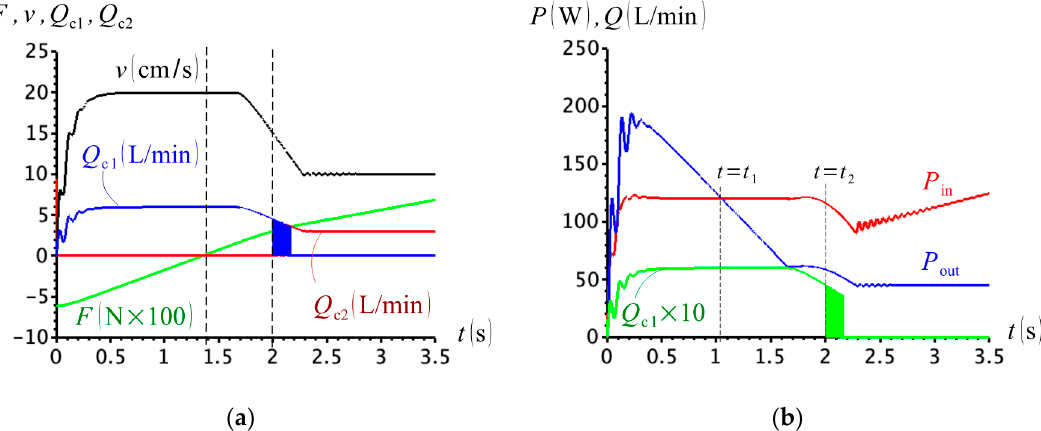
Figure 27. ( a ) External force, cylinder velocity and compensation flows; ( b ) input and output powers at the cylinder and cap-side compensation flow ( m = 0.5 kg and p cr = 1.0 × 10 − 6 bar).